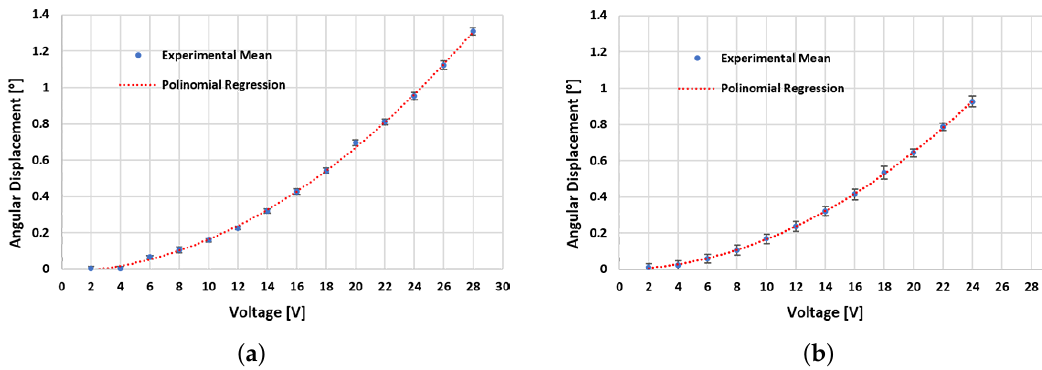
Figure 11. Relationship between angular displacement vs the applied voltage for the OPS ( a ) and the LTM ( b )